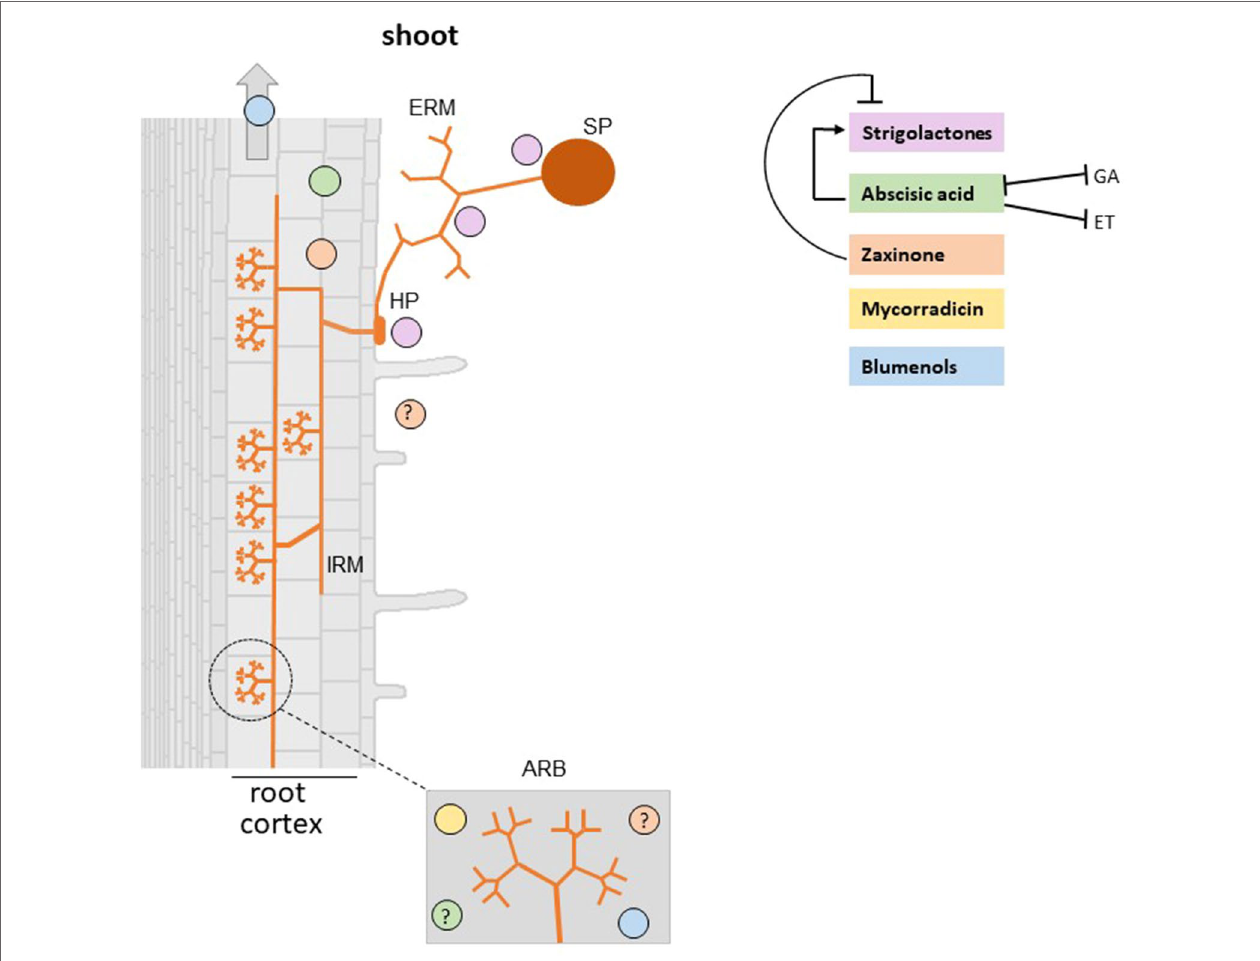
FIGURE 2 | Carotenoid derived-hormones and apocarotenoid signaling molecules involved in the establishment of AM symbiosis. Plant roots release SLs which stimulate AMF spore germination, hyphal branching, hyphopodia formation, and metabolism that in the end promote root colonization. Abscisic acid (ABA) deficient mutants show a reduction of AMF colonization and arbuscule formation and functionality (Herrera-Medina et al., 2007; Martín-Rodríguez et al., 2011). However, it is unclear whether ABA effect on the AM symbiosis is mediated by a cross-talk with SLs, ethylene, and gibberellins. Mycorradicins and blumenols are accumulated in arbuscule-containing cells (Walter et al., 2010). Moreover, Wang et al. (2018) demonstrated that blumenols accumulate also in shoots of several mycorrhizal plants and proposed them as foliar markers for a rapid screening of functional AMF associations. Recent findings showed that zaxinone is produced in mycorrhizal roots and a rice zaxinone defective mutant displays lower AM colonization levels (Wang et al., 2019). SP, spore; HP, hyphopodium; IRM, intraradical mycelium; ERM, extraradical mycelium; ARB, arbuscule-containing cells. Note that the specific localization of ABA and zaxinone is not known (indicated with a question mark). Positive and negative effects are illustrated by arrows and blunt-ended bars,